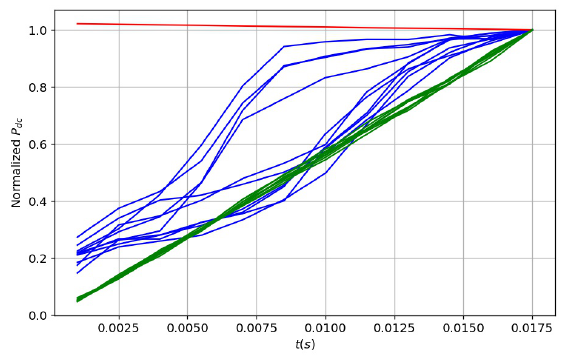
Figure 12. Radiometric linearity curves of valid pixels (green line), invalid pixels (blue) and dead pixel